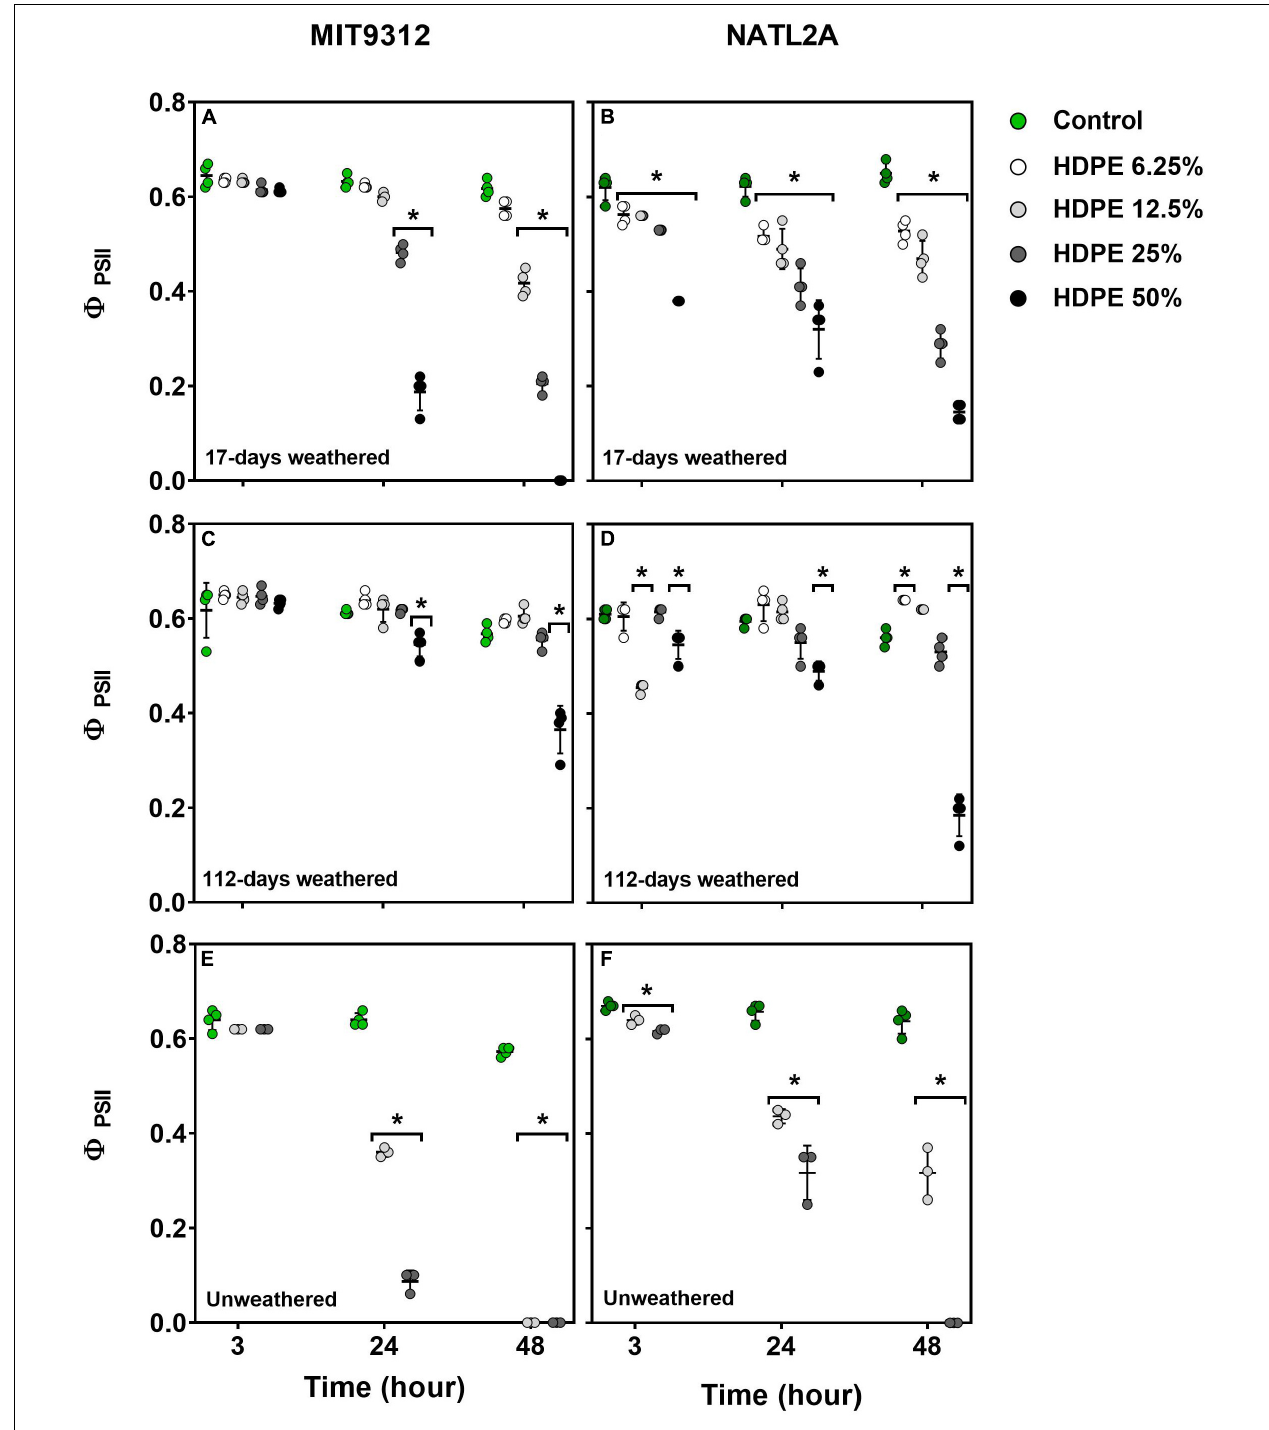
FIGURE 2 | Effective quantum yield of photosystem II ( (cid:56) PSII ) for Prochlorococcus MIT9312 and NATL2A exposed to different dilutions of HDPE leachates ( A,B , weathered for 17-days; C,D , weathered for 112-days; E,F , unweathered) following different exposure times in hours. Experiments were conducted over 48 h using biological replicates ( n = 4 for all weathered control and leachate treatments; n = 3 for all unweathered control and leachate treatments). Symbols represent the value for each replicate culture, the bar represents the mean ± standard deviations for the treatment at each time point. Asterisks (*) signify treatments for which measurements were significantly ( p < 0.01) different compared to the control at the same